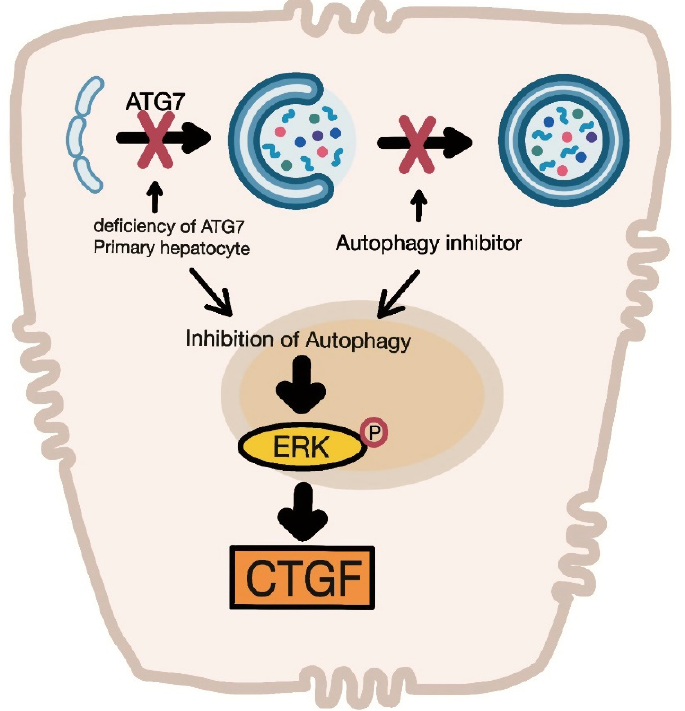
Figure 7. Increased levels of phosphorylated ERK induce CTGF expression in autophagy-deficient mouse hepatocytes.